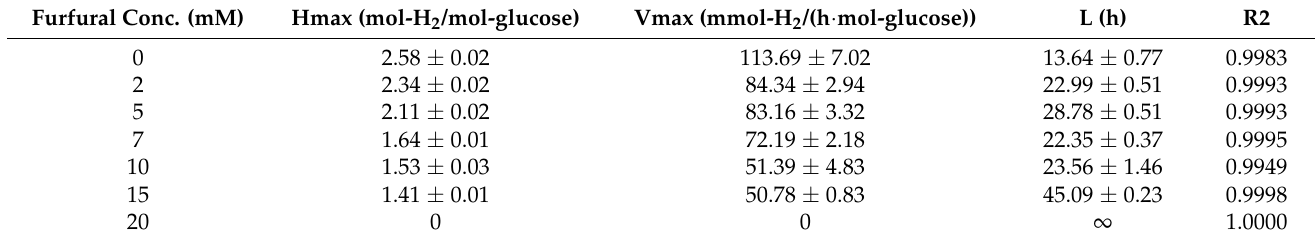
Table 1. Effects of various furfural concentrations (0 – 20 mM) on hydrogen production potential, maximum hydrogen production rate, lag phase.